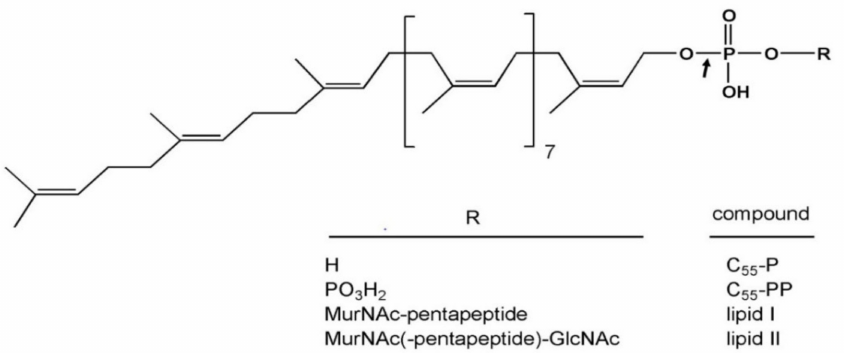
Figure 6. Structure of the C 55 -P carrier lipid derivatives. The arrow indicates the site of cleavage by ColM in the peptidoglycan lipid I and lipid II